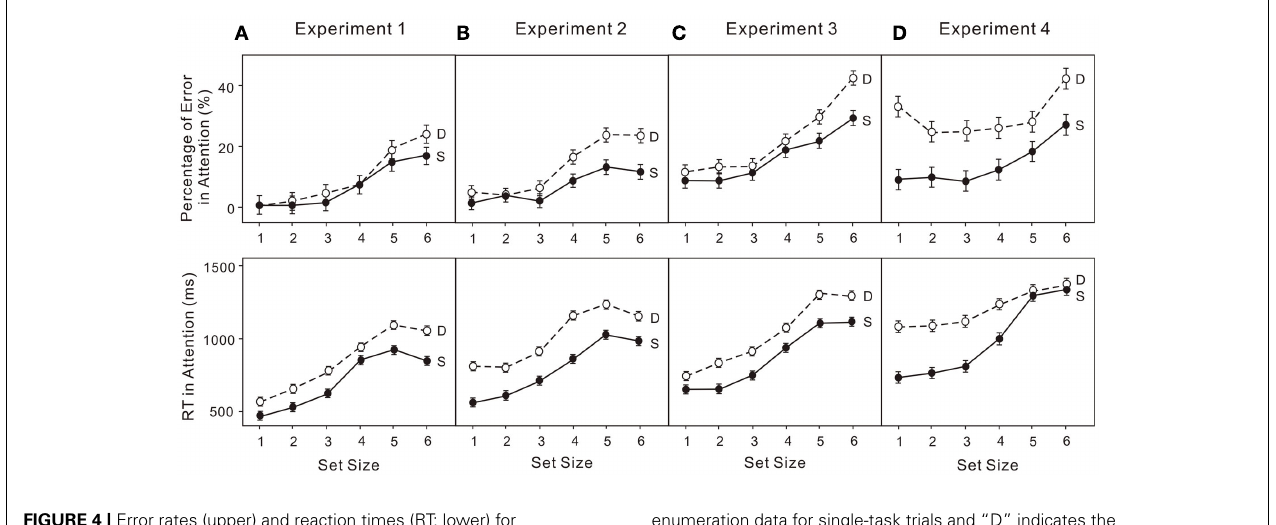
FIGURE 4 | Error rates (upper) and reaction times (RT; lower) for attentional tasks in: (A) experiment 1 (low attentional load); (B) experiment 2 (low attentional load); (C) experiment 3 (high attentional load); (D) Experiment 4 (high attentional load). “S” indicates the